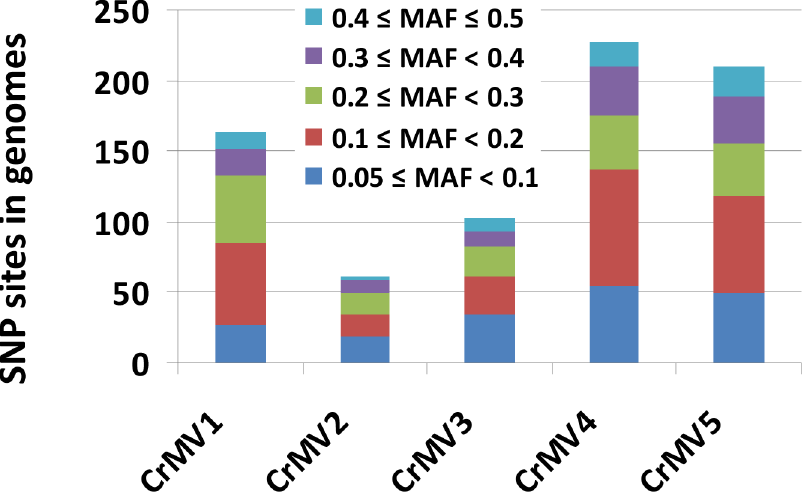
Fig 6. Distribution of minor allele frequency (MAF) of single nucleotide polymorphism (SNP) sites in the genomes of Cronartium ribicola mitoviruses (CrMV1 to CrMV5) as detected by RNA-Seq